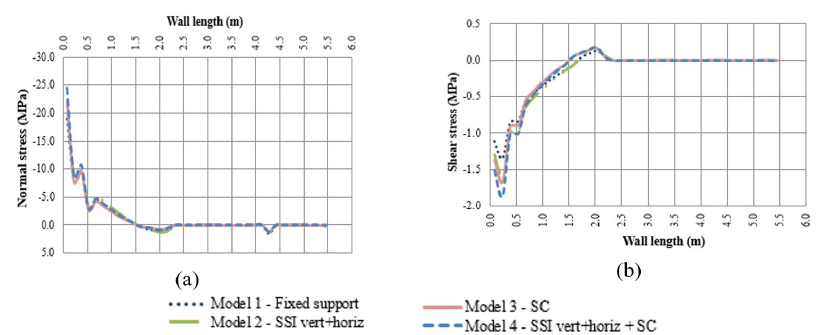
Figure 11. Distribution of stresses at the base of wall 45: (a) Normal stresses; (b) Shear stresses.